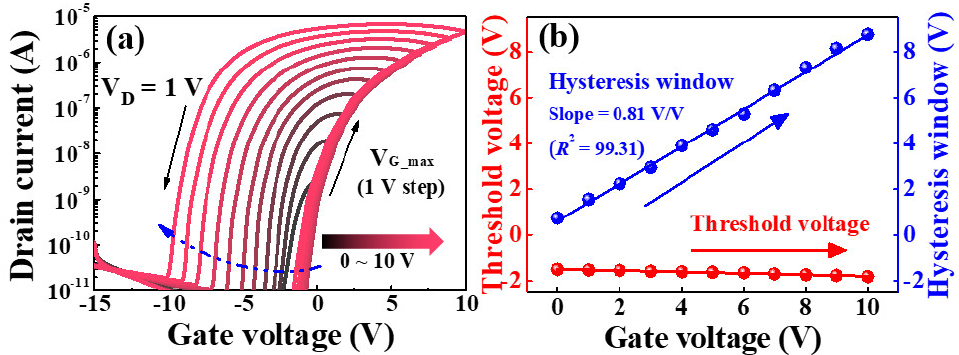
Figure 4. ( a ) Double−sweep transfer curves, and ( b ) hysteresis window and threshold voltage characteristics as a function of maximum gate sweep voltage.